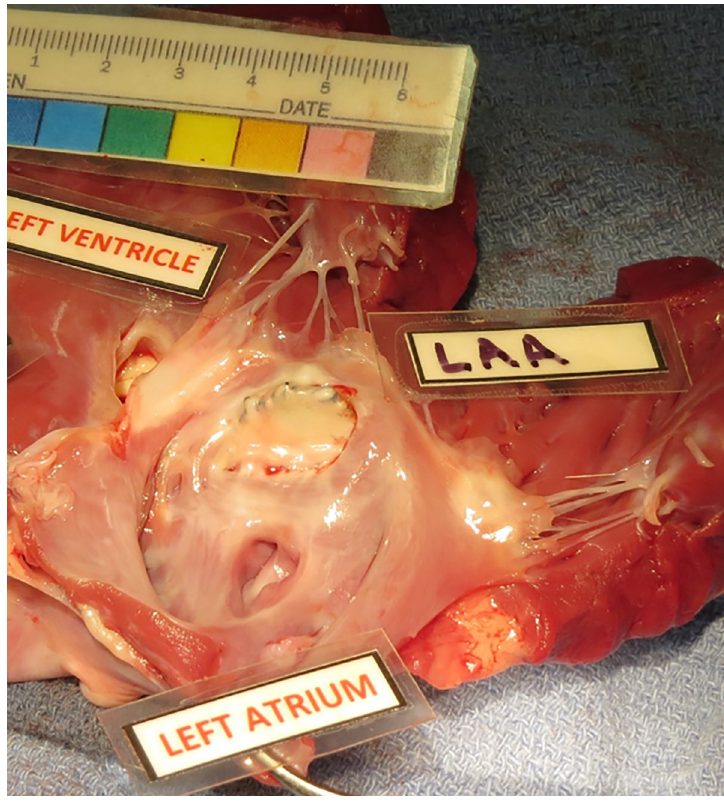
Fig 3. StrokeShield device in situ . The StrokeShield device in the LAA at necropsy (day 60) in the chronic canine model demonstrating tissue encapsulation and freedom from interference with the mitral valve and pulmonary veins. https://doi.org/10.1371/journal.pone.0253299.g003 LAA occlusion devices are designed to block and/or fill the LAA ostium, which if not completely occluded, can result in blood leakage and stagnation near the exposed surrounding edges of the LAA orifice increasing the potential risk for thrombogenesis (and stroke). LAA